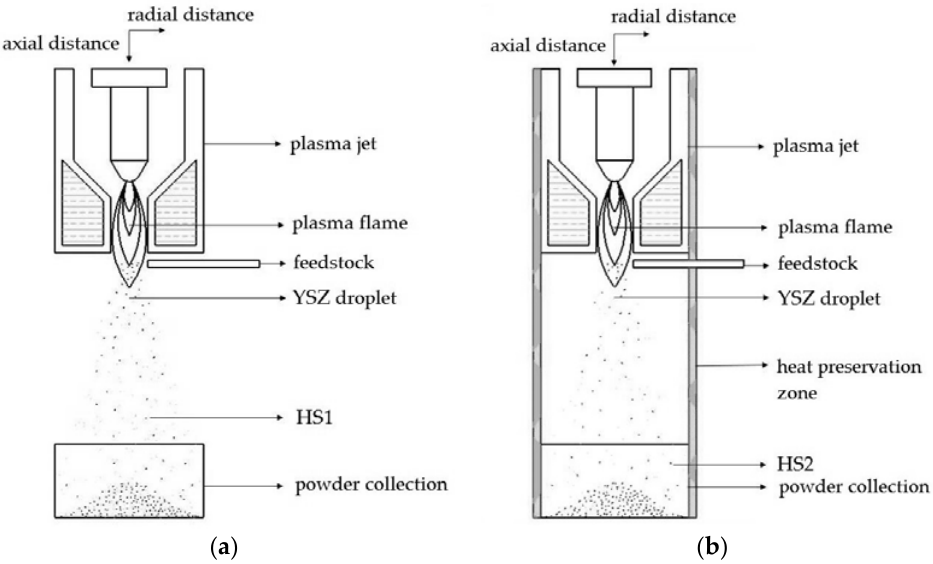
Figure 1. Preparation of HS1 and HS2 by different plasma process: ( a ) process without heat preservation zone; ( b ) process with heat preservation zone.